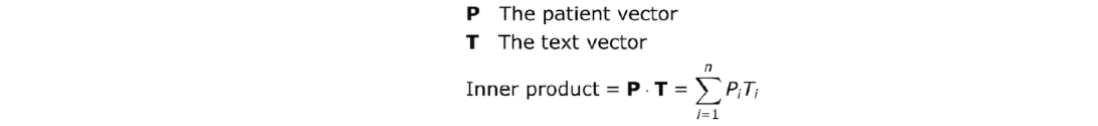
Figure 5. Inner product of the patient vector and text